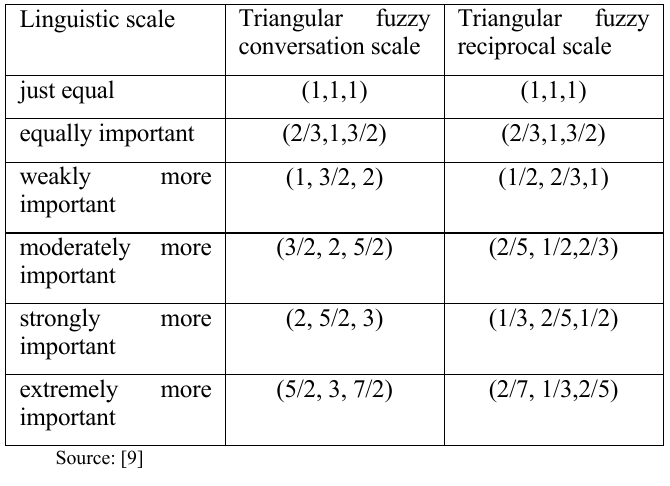
TABLE I. T RIANGULAR FUZZY COLLOQUIAL SCALE